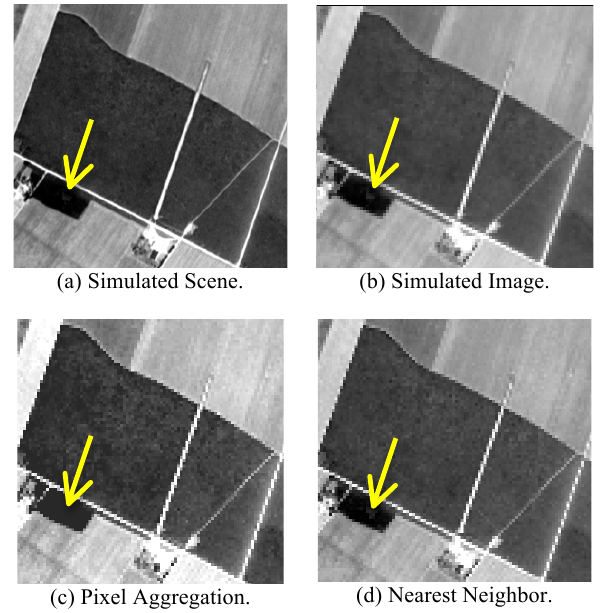
Figure 4. Red band – Resampling Differences.